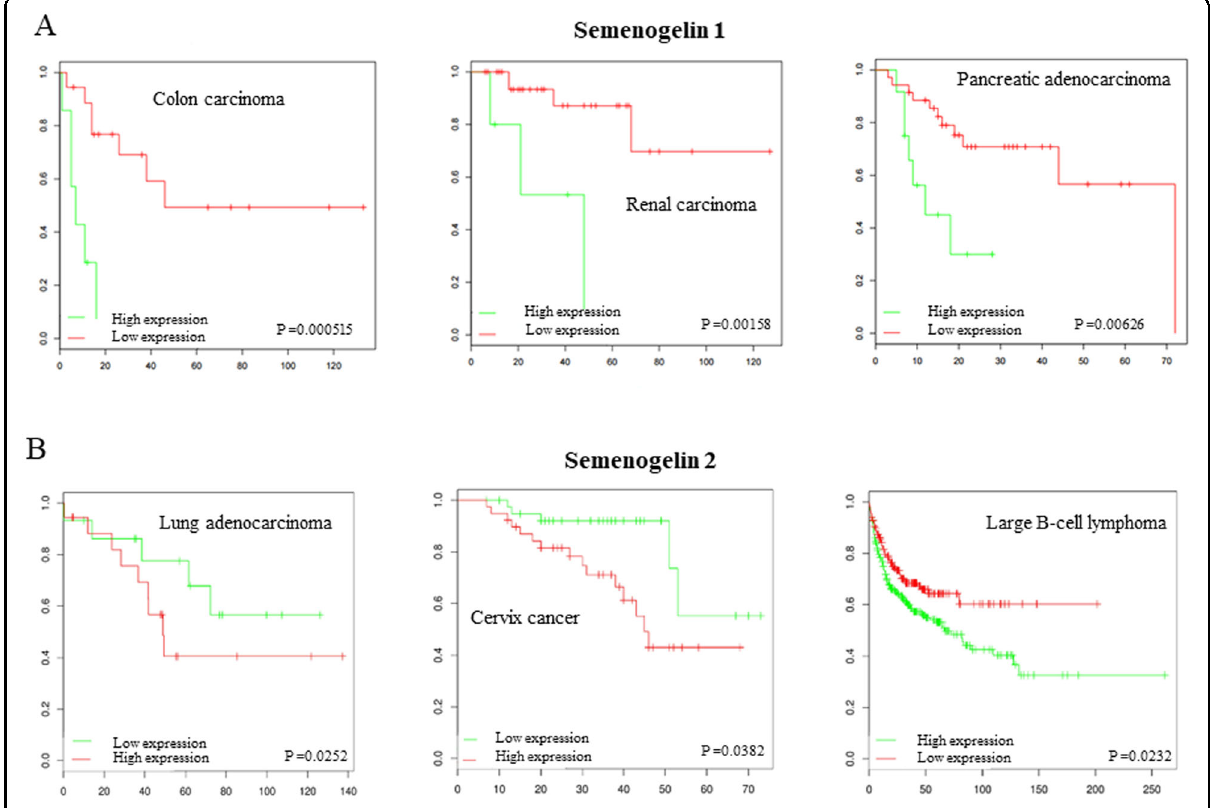
Fig. 2 The expression level of SEMG1and SEMG2 negatively associated with survival rate of cancer patients. Kaplan – Meier plots demonstrating the associating between mRNA levels of A SEMG1 or B SEMG2 and outcome of patients with different types of cancer. PPIsurv software (http://www.biopro fi ling.de/GEO/PPISURV/ppisurv.html) using algorythms described by Antonov et al. 17 and publically available Gene Expression Omnibus (GEO) microarray data were